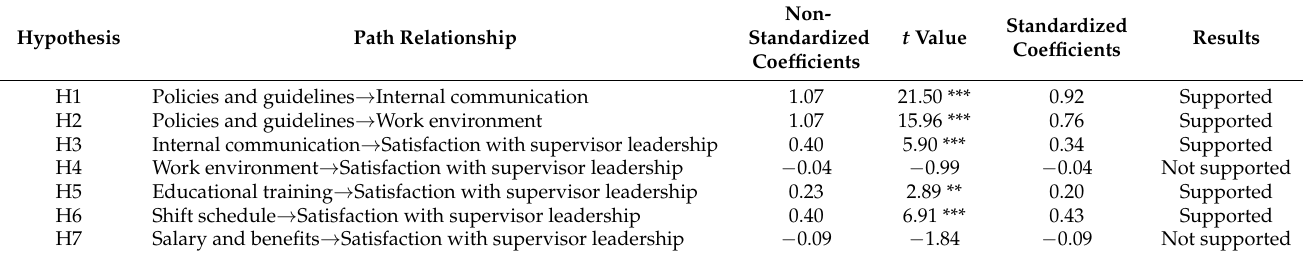
Table 4. Relationship analysis of the structural equation model.